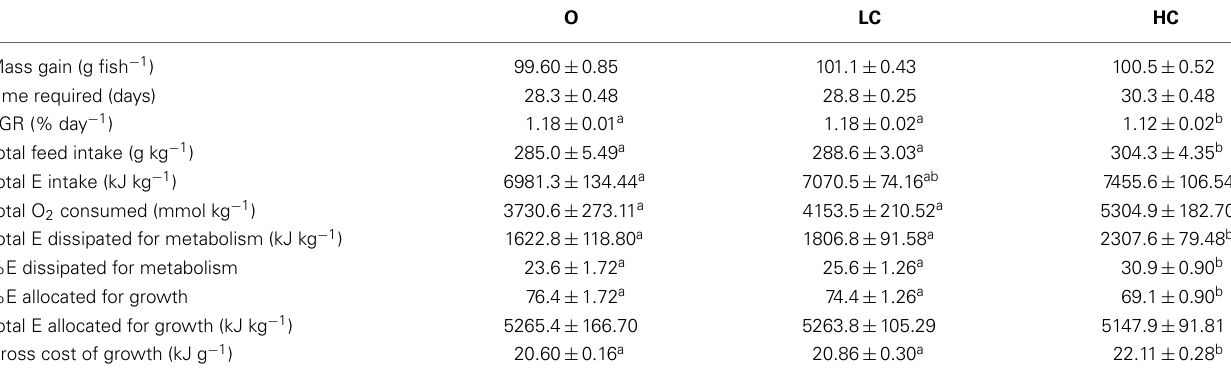
Table 2 | Energetic parameters in fish reared under three different current speeds, high current, HC = 1 BL s − 1 ; low current, LC = 0.5 BL s − 1 ; and O = no current (mean ± SE, n = 4, except for O, where n = 3 in O 2 consumed, E dissipated, E allocated and gross cost of growth).